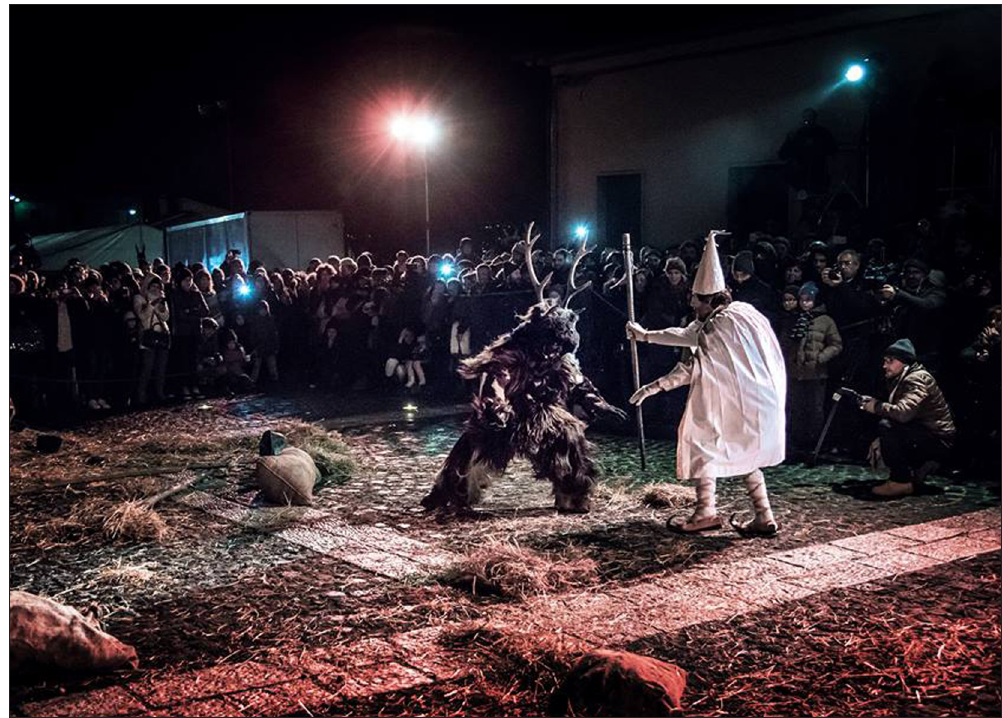
Figure 1: A moment in the pantomime of the deer-man. (Photo: Lorenzo Albanese, Castelnuovo al Volturno